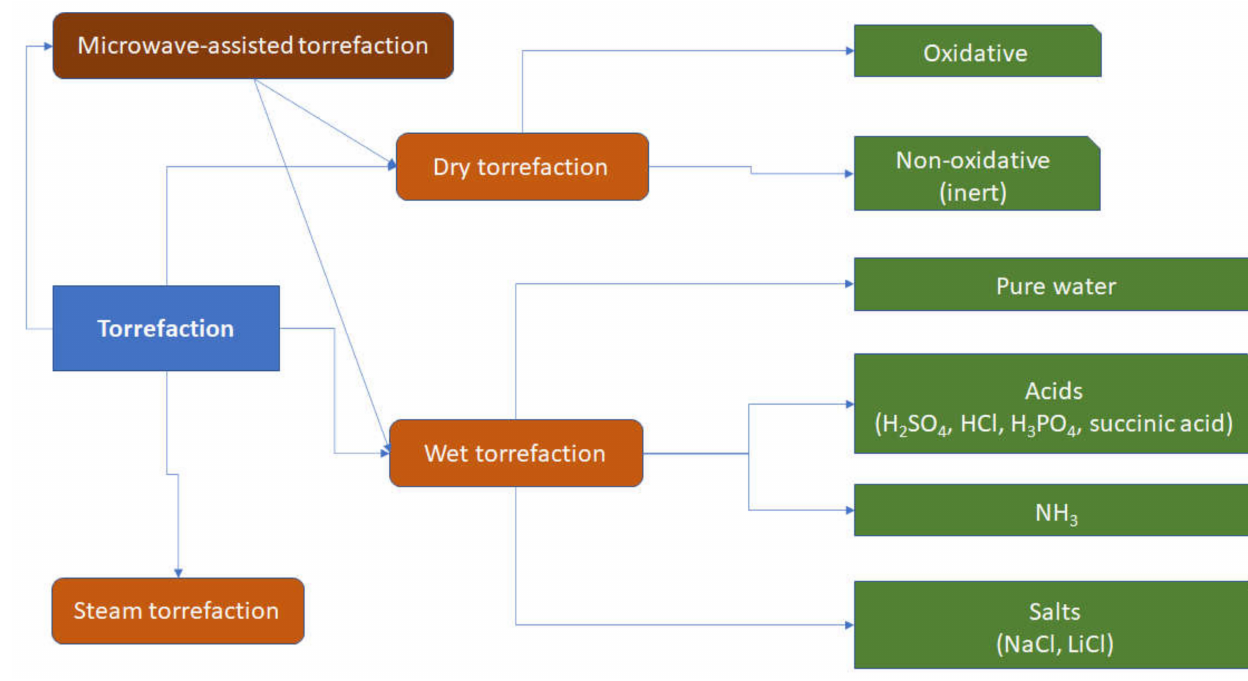
Figure 1. Classification of